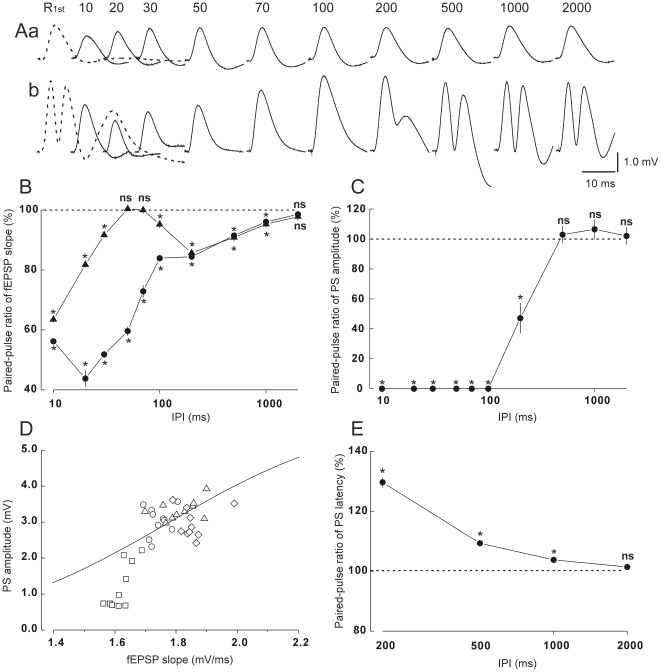
Paired-pulse responses under the non-drug condition.A: waveforms of response to the first stimulation pulse (R1st, broken line) and that to the second stimulation pulse (solid lines) at each inter-pulse interval (IPI) with low (a) or high (b) intensity stimulus. The numbers at top line, IPIs. Each waveform is an average of 10 LFPs. B: paired-pulse ratios for fEPSP slopes at low (triangles) or high stimulus intensity (circles) as a function of IPIs. C: paired-pulse ratios for PS amplitudes as a function of IPIs. D: relationships between fEPSP slopes and PS amplitudes in response to the second stimulation pulse at IPI of 200 (squares), 500 (circles), 1000 (triangles) and 2000 ms (diamonds). E: paired-pulse ratios for PS latencies as a function of IPIs. In B, C and E, vertical lines through each data point indicate standard error of means, and horizontal broken lines indicate paired-pulse ratio of 1 (100%). Other descriptions as for Fig. 1. Asterisks, p<0.05 in paired t-tests.